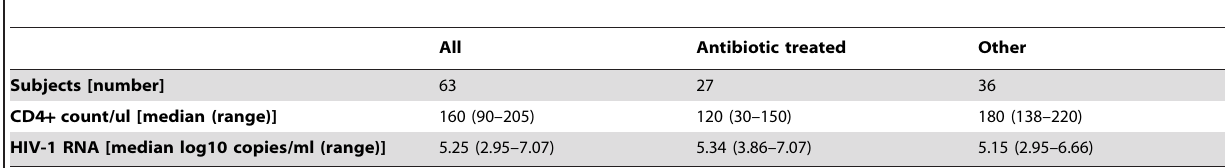
Table 1. Baseline characteristics of antibiotic treated